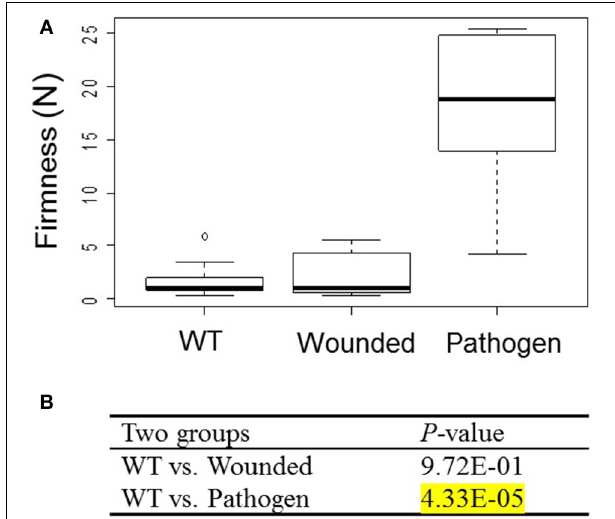
FIGURE 4 | Effect of wounding and pathogen infection on fruit firmness of F. × ananassa cv. Elsanta. (A) WT (Wild type; n = 10); fruits infiltrated with MMA medium (wounded; n = 12) and Agrobacterium (pathogen; n = 10). (B) The Wilcoxon-Mann-Whitney U- test was used for a non-parametric comparison of two groups from WT and wounded or pathogen-infected fruits. Values showing statistically significant increased levels ( P < 1 . 00E-02) are marked by a yellow background.